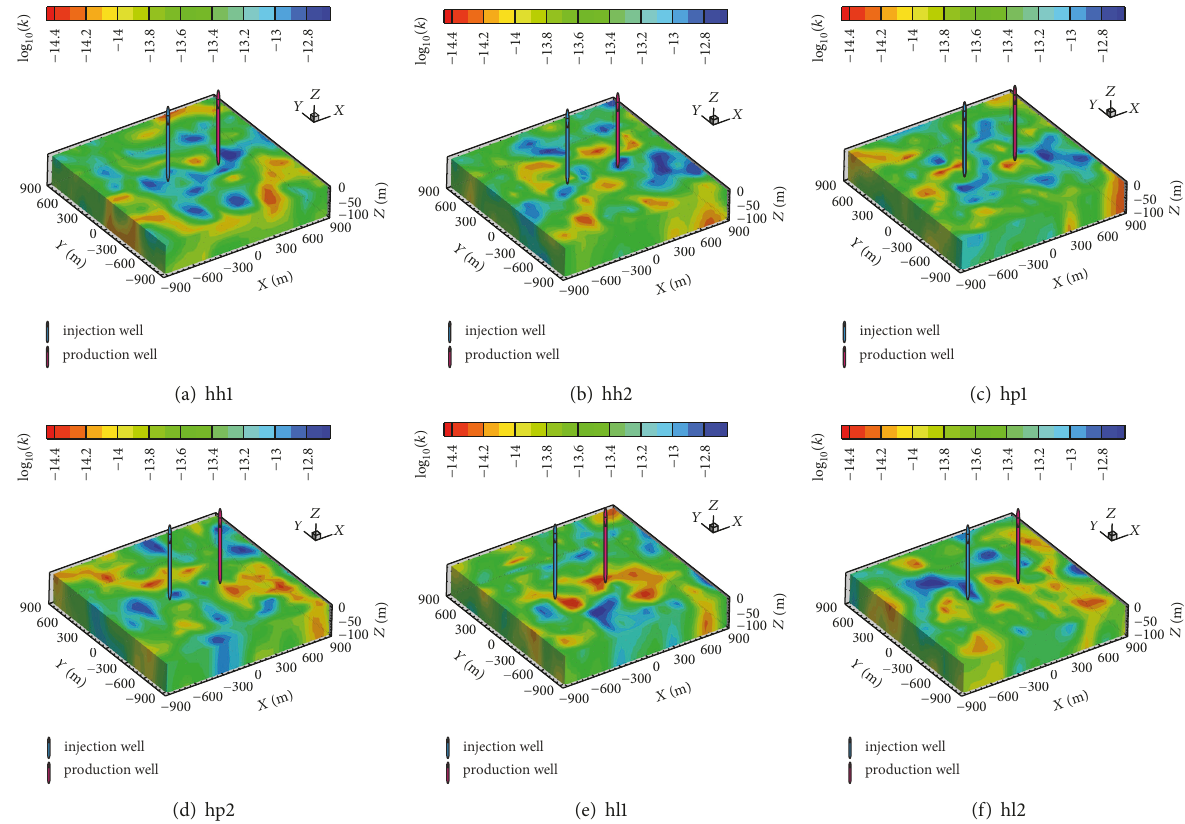
Figure 2: Permeability distribution of six heterogeneous cases.